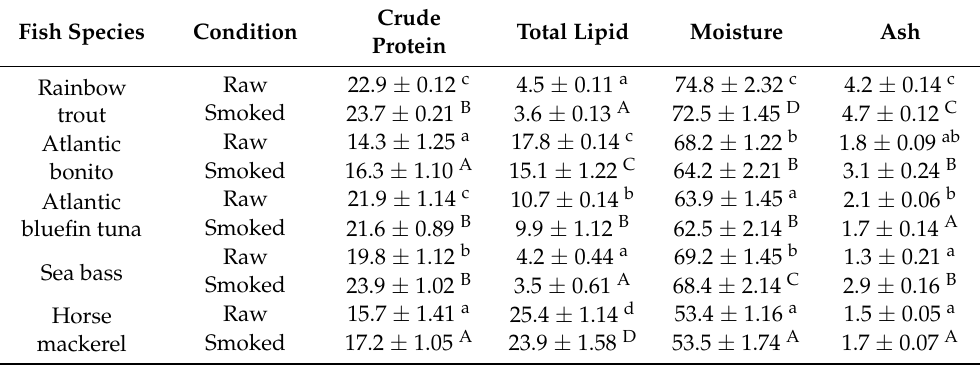
Table 1. Proximate composition in the fresh and smoked fillets of fish species. Fish